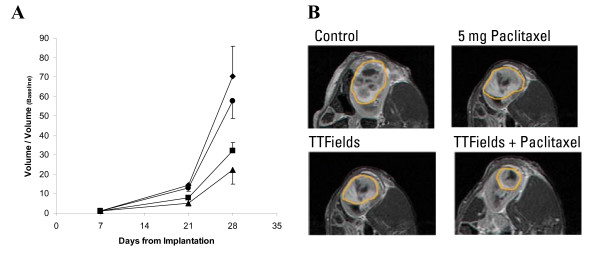
Effect of combined Paclitaxel/TTFields on VX2 tumors in Rabbits. A VX-2 Kidney tumor volumes were normalized to pre-treatment tumor volume (day 7) and are presented over time for; control (diamonds), 5 mg Paclitaxel (circles), TTFields (squares) and combined TTFields-Paclitaxel (triangles). The effect of combined TTFields and Paclitaxel is equal to the sum of the effects of either treatment alone at both time points measured during the study (2 and 3 weeks from treatment start; n = 23; bars are standard errors of means). B Exemplary MRIs of the maximal contrast enhancing tumor area (demarcated by orange boarders) in the kidneys of rabbits in each of the experimental groups (sham control, Paclitaxel 5 mg, TTFields 2 V/cm, combined Paclitaxel and TTFields).